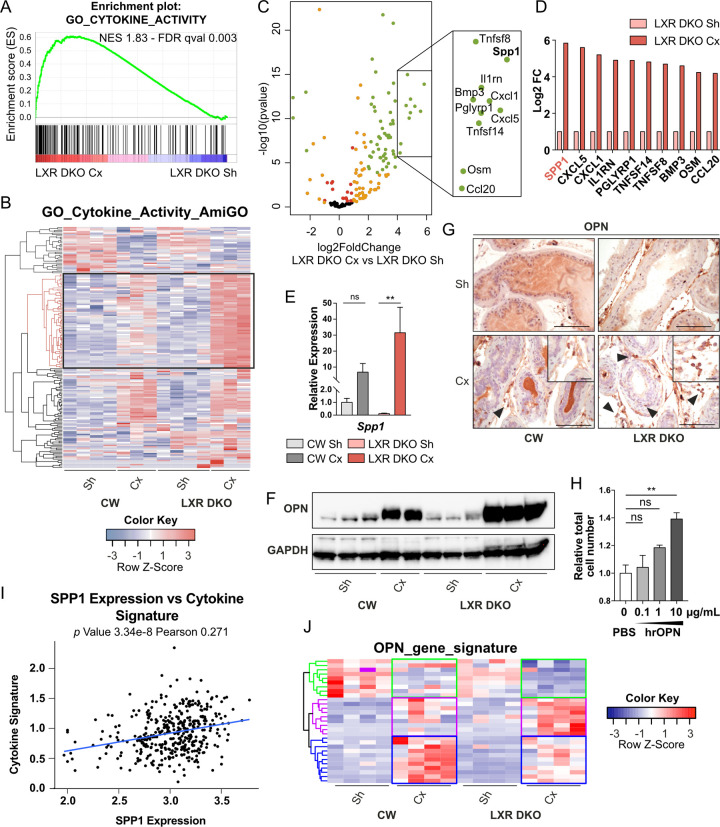
Inflammatory cytokine OPN is up-regulated in LXR-null prostate in response to androgen deprivation.(A) GO analysis of RNA sequencing reveals enrichment in genes annotated by the cytokine activity GO term GO:0005125 from MSigDB after 1 month of castration in LXR DKO mice in comparison with Sh mice. (B) RNA sequencing analysis of cytokine activity coding genes annotated by the GO term GO:0005125 according to AmiGO 2 annotation. (C) Volcano plot of cytokine activity coding genes shows differential gene expression in 1-month Cx LXR DKO compared with Sh LXR DKO mice. Most of the genes are statistically deregulated (padj < 0.05—red), with an abs(logFC) >1 (orange). Among them, a large number of genes are strongly up-regulated (abs(logFC) > 2, padj < 0.001—green). (D) Top 10 list of the most up-regulated genes in the 1-month Cx versus Sh LXR DKO mice. (E) RT-qPCR analysis of the most deregulated gene OPN coding gene Spp1, in response to 1-month castration in LXR DKO prostates. (F and G) Western blot analysis (F) and immunohistochemical detection (G) of OPN. OPN protein is expressed at high levels in prostate stroma and low levels in epithelial cells of LXR DKO mice, in response to 1-month castration. Groups are composed of at least 4 animals. Bars represent mean ± SEM. Statistical analyses were performed via Mann–Whitney test. Scale bars, 100 μm; insets, 20 μm. (H) P69 benign epithelial prostate cells were treated by increasing doses of hrOPN for 24 hours. A pro-proliferative effect was observed under stimulation by 10-μg/mL hrOPN. (I) Correlation plot between SPP1 expression and cytokine signature of LXR DKO mice using TCGA cohort [72] (J) Heatmap of OPN putative target genes [25], identification of 3 gene clusters differentially deregulated (green, purple, and blue). Bars represent mean of triplicates ± SEM. Statistical analyses were performed via Kruskal–Wallistest. *p < 0.05, **p < 0.01, ***p < 0.001 and ns. For numerical raw data, please see S1 Data. For raw immunoblots, please see S1 Blots. For supporting dataset, please see S2, S7 and S8 Datas. Cx, castrated; GO, gene ontology; hrOPN, human recombinant osteopontin; LXR, liver X receptor; LXR DKO, LXR alpha and beta double knock-out; ns, nonsignificant; OPN, osteopontin; Sh, sham-operated; RT-qPCR, quantitative reverse transcription PCR; SPP1, secreted phosphoprotein 1; TCGA, The Cancer Genome Atlas.